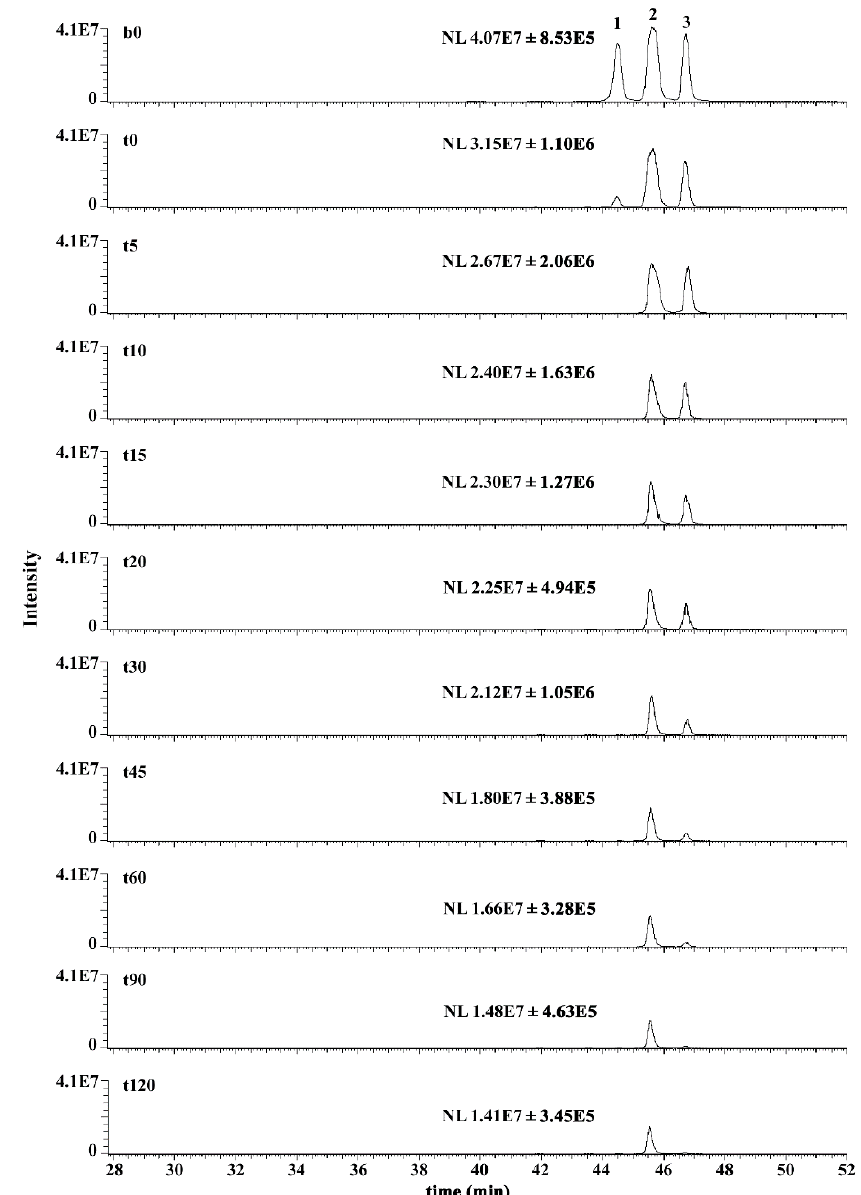
Figure 2. Nano-LC-ESI-LIT-MS analysis of the reaction mixture containing h AKR1B1, GSHNE and NADPH. Reported are the extracted ion currents (EIC) relative to GSHNE (i.e., m / z 464.25), which were measured for the 10 sampling times (from t0 to t120) of the reaction mixture (see Section 2.6) and for the reference reaction mixture b0 without h AKR1B1. Sample t0 refers to a sample withdrawn from the reaction mixture just after the addition of h AKR1B1. For each sampling time, normalized intensity levels (NLs) are reported as the mean values ± SD determined over five chromatographic runs; NL refers to the largest peak of the GSHNE triplets 1, 2 and 3.